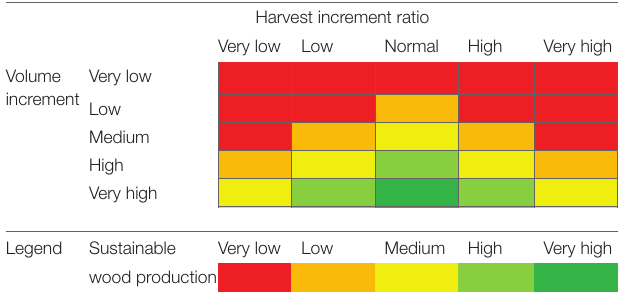
TABLE 3 | Fuzzy rule set for biodiversity assessment (modified after Biber et al., submitted).